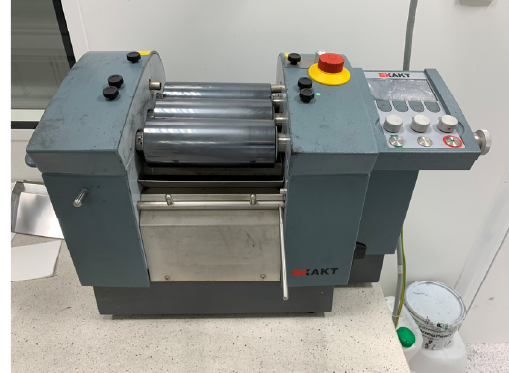
Figure 1. Three ‐ roll mill EXAKT model 80E . Figure 1. Three-roll mill EXAKT model